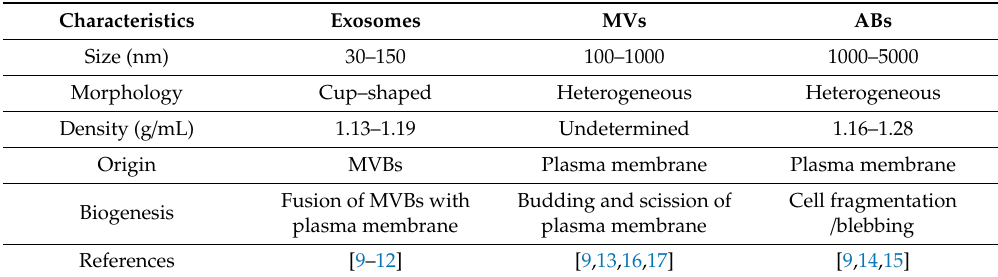
Table 1. Extracellular vesicle (EV)